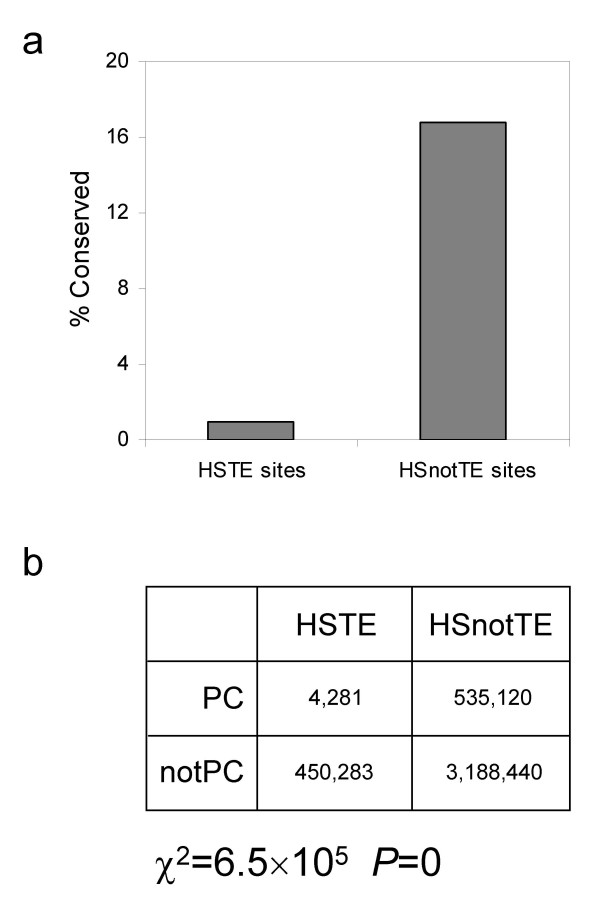
Evolutionary conservation of TE-derived versus non TE-derived HS sites. a) The percent of phastCons (PC) denoted conserved positions for TE-derived (HSTE) and non TE-derived (HSnotTE) sites in the human genome. b) 2 × 2 contingency table for evaluating the difference in evolutionary conservation between HSTE and HSnotTE sites.